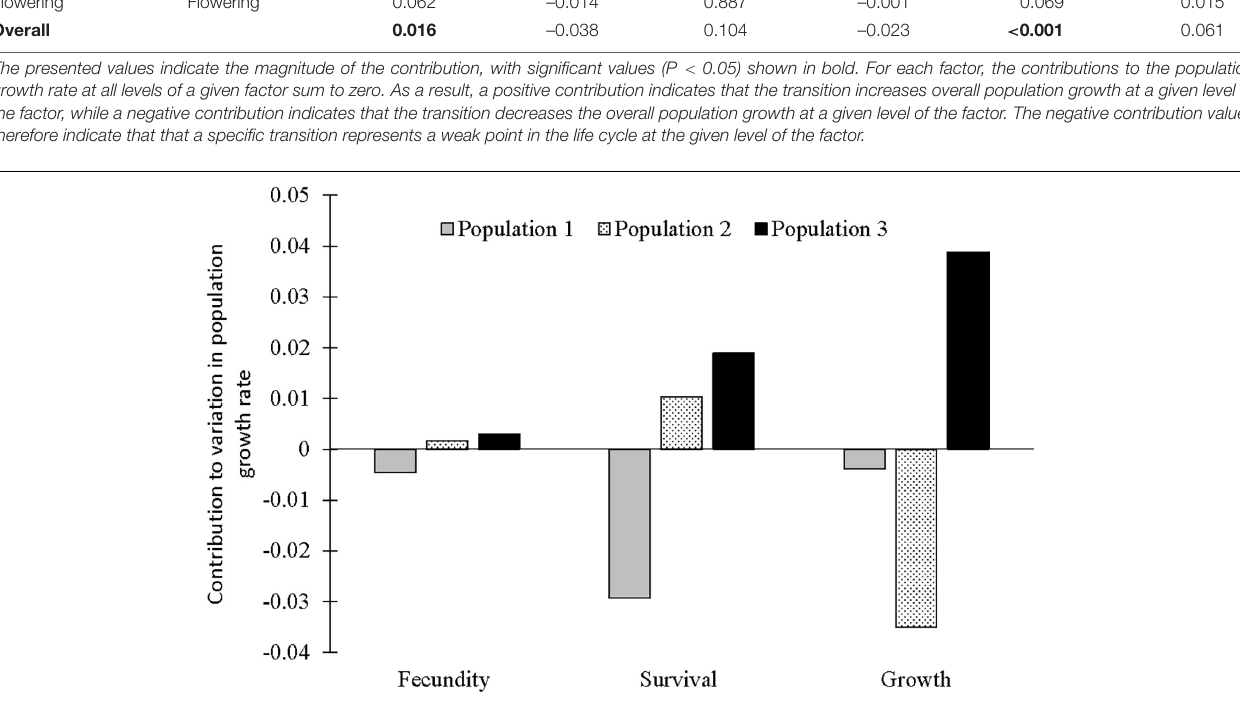
FIGURE 4 | Result of LTRE analysis showing positive and negative contributions of three populations to the observed variation in overall stochastic population growth rate grouped by life history components (survival, i.e., stasis and retrogression, fecundity and